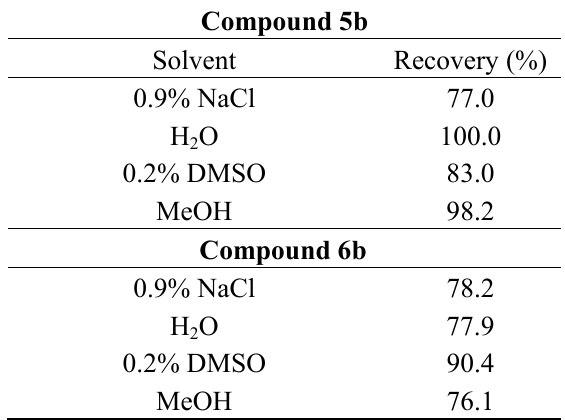
Table 2. Sample recovery (arithmetic mean) after 72 h in the specific environment.